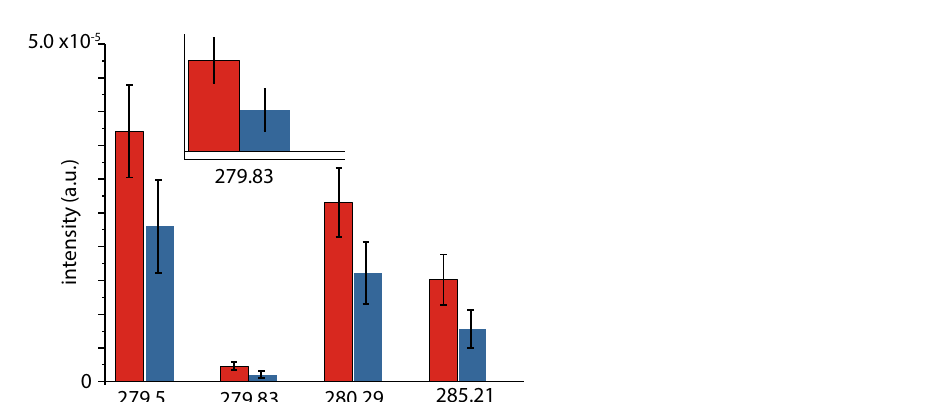
Figure 3. Comparison of the emission intensity of Na I and Mg I–II transitions in positive (red), and negative treated (blue) samples. The error bars represent the fitting error of the average spectra of positive (P) and negative (N).Transitions based on Refs. 14,15 .